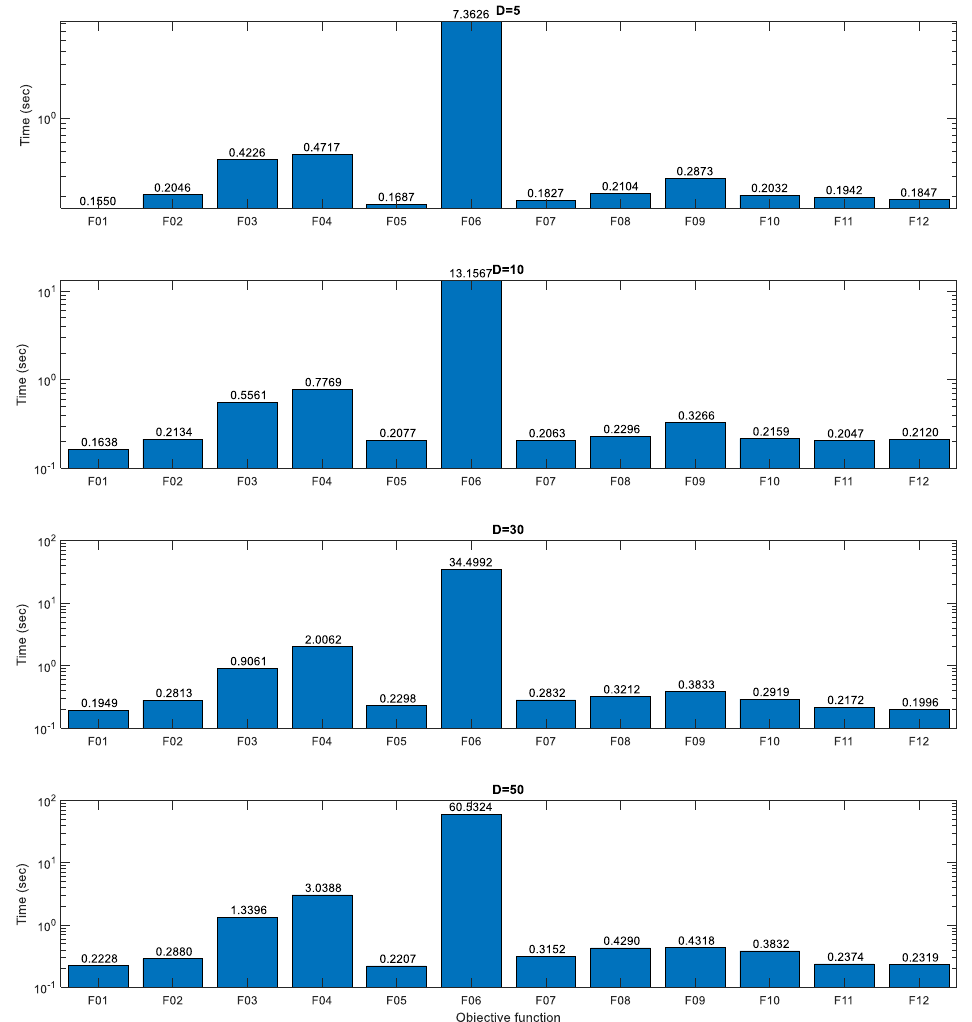
Figure 3. Time needed for the calculation of each objective function 100,000 times, for a random vector of 5, 10, 30 or 50 variables ( D = 5, 10, 30, 50). The y-axis is in logarithmic scale.